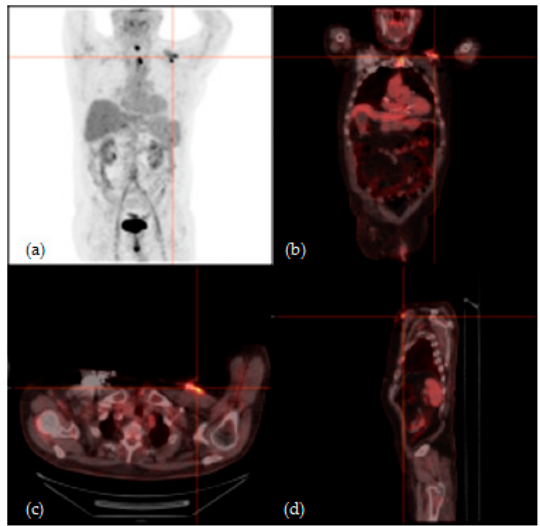
Figure 1. 18 F-fluorodeoxyglucose positron-emission tomography/computed tomography ( 18 F-FDG PET/CT) of a 78-year-old man with suspicion of cardiac implantable electronic device (CIED) infection because of bacterial blood culture positive for Staphylococcus epidermidis . ( a ) Maximum intensity projection (MIP), ( b ) coronal fusion, ( c ) axial fusion and ( d ) sagittal fusion images showed increased 18 F-FDG uptake involving the CIED pocket. After surgical CIED removal, microbiological analysis of explanted materials confirmed Staphylococcus epidermidis infection.